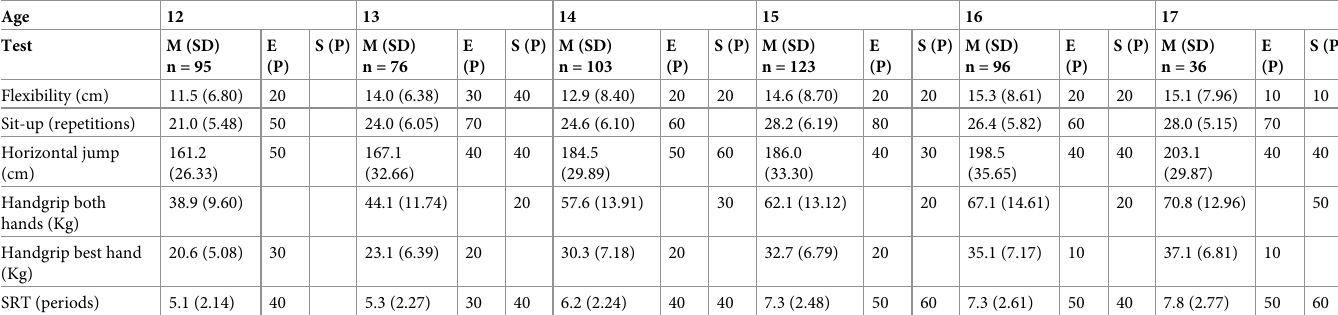
Table 2. Descriptive data of age-specific physical fitness test results in boys with comparative percentile based on baseline